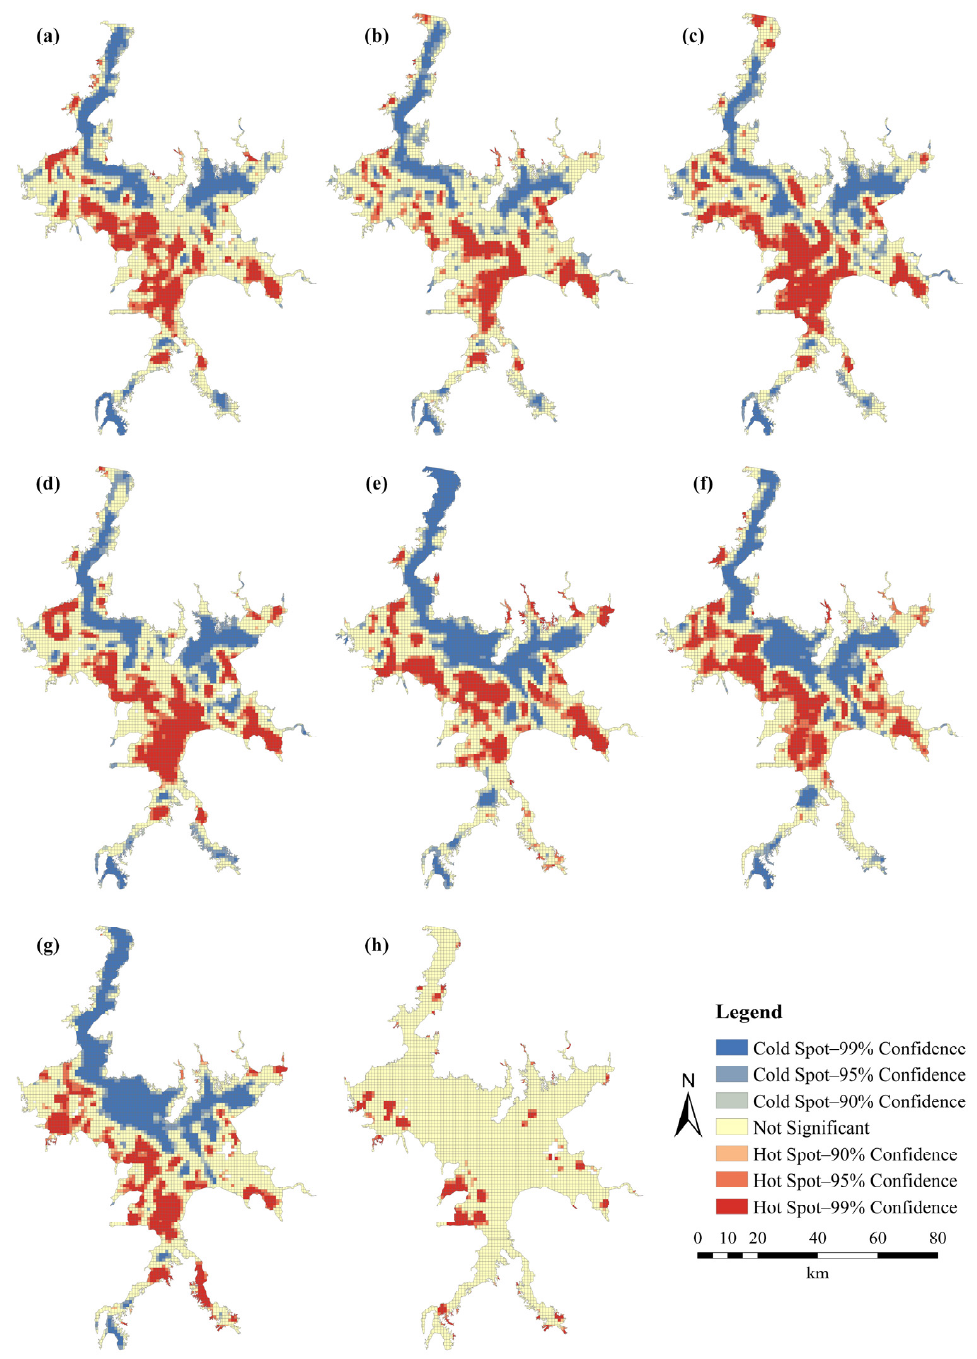
Figure 7. Hot and cold spots of the sustainable crane habitats within various water level intervals: